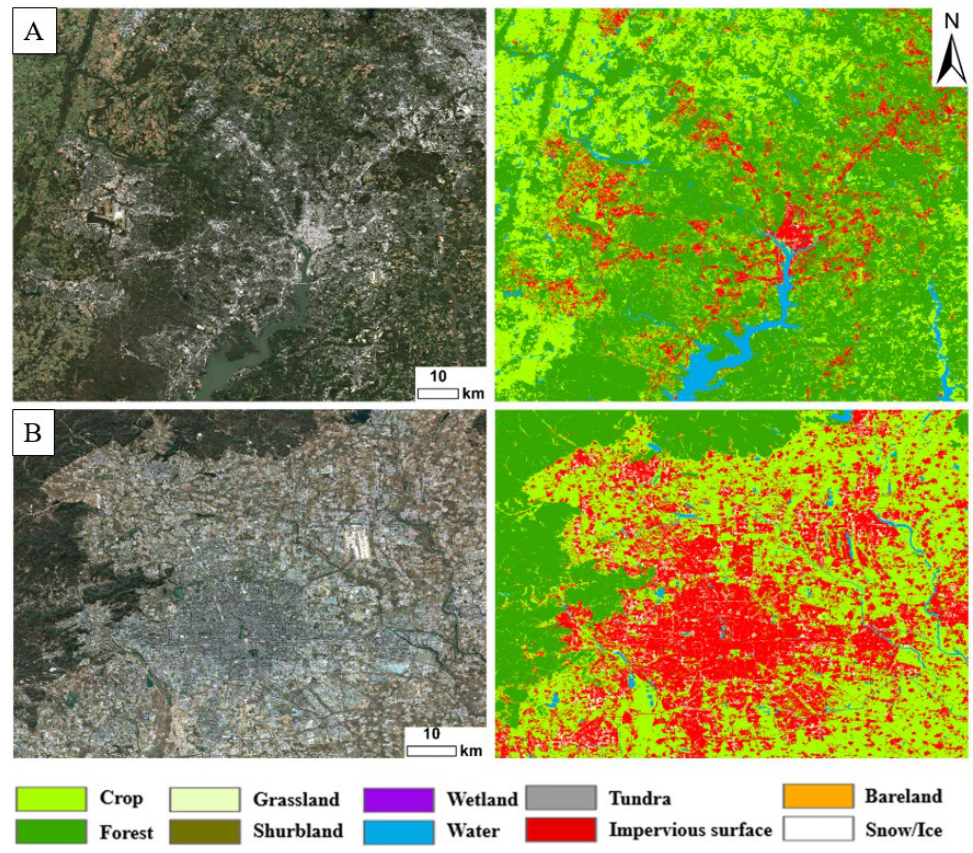
Figure 6. Large-scale mapping of other regions in Washington D.C. ( A ) and Beijing ( B ).